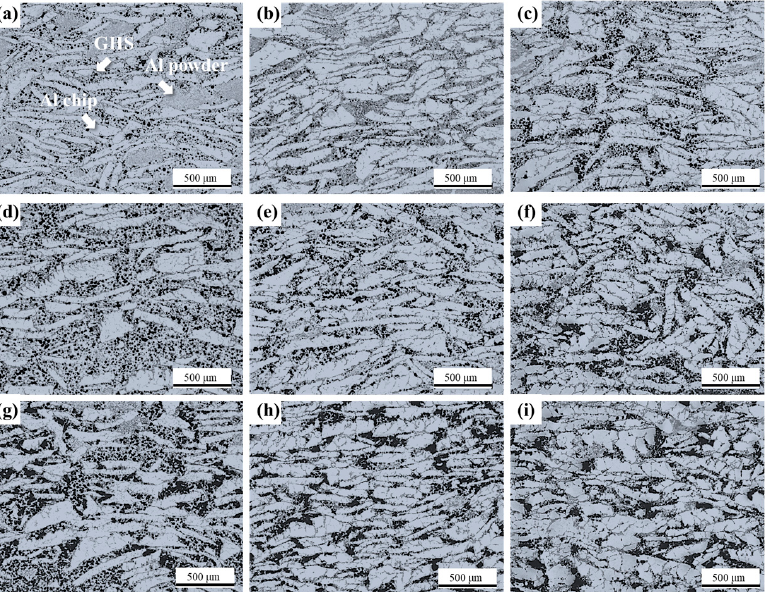
Figure 6. 50x magnification OM image of microstructures of each sample; ( a ) Al50G5, ( b ) Al60G5, ( c ) Al70G5, ( d ) Al50G10, ( e ) Al60G10, ( f ) Al70G10, ( g ) Al50G15, ( h ) Al60G15, ( i ) Al70G15.